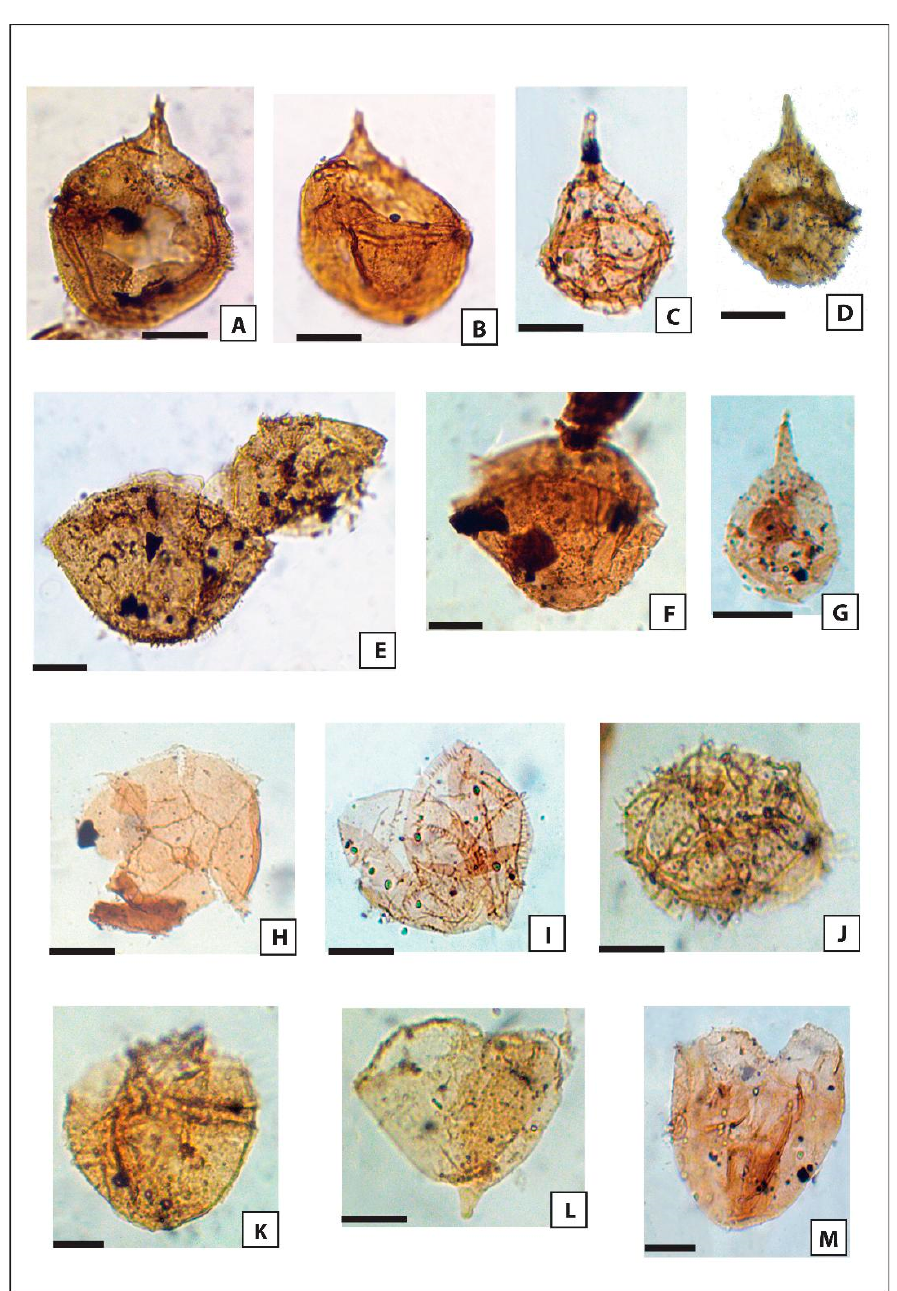
Figure 4. Photomicrographs of the recovered dinoflagellate cysts and microforaminiferal test linings from the Khatatba Formation taken under transmitted white light. The corresponding well name, sample depth, slide number, and coordinates of the species in the kerogen slides are given. The scale bar is equivalent to 30 µ m. ( A , B ) Cribroperidinium globatum , OBA D-10, 3928 m, slide 1, Coord. 38.1/12; OBA D-8, 3820 m, slide 1, Coord. 34/8.5. ( C ) Gonyaulacysta cf. adecta , OBA D-10, 3910 m, slide 1, Coord. 44/4.5. ( D ) Gonyaulacysta adecta THAX-1, 3786 m,